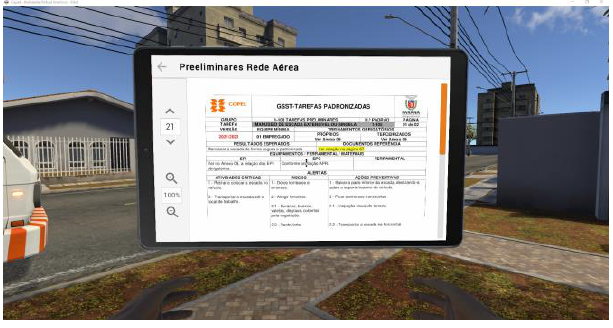
Figure 24. Viewing a safety document in the Virtual Tablet.